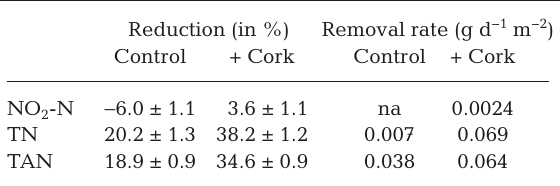
Table 7. Summary of single-pass biofilter efficiencies and removal rates for nitrite-nitrogen (NO 2 -N), total nitrogen (TN) and total ammonia nitrogen (TAN). Values are means ± SE. na: not